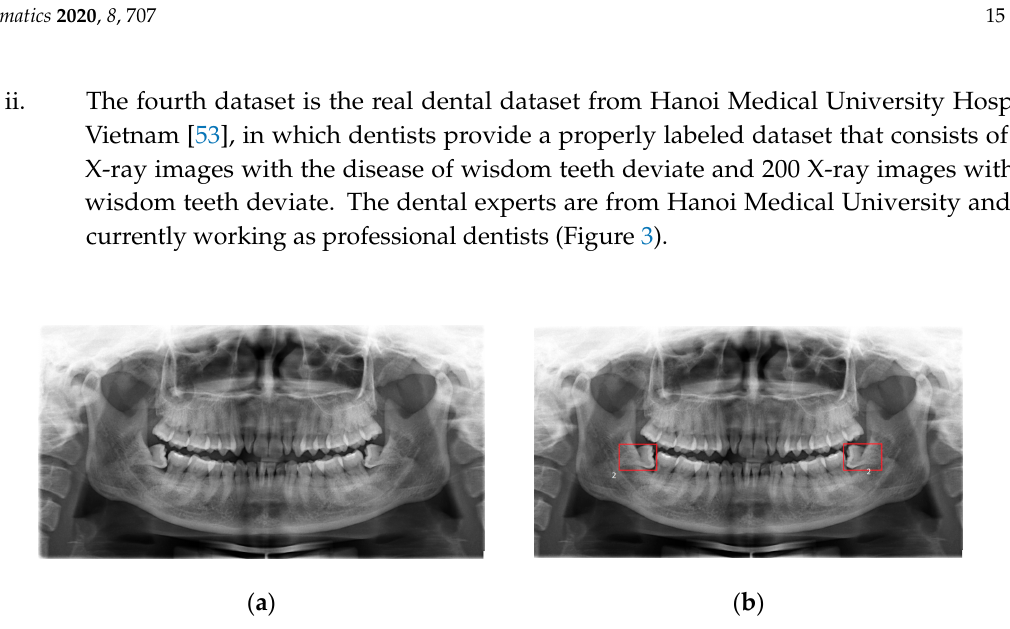
Figure 3. ( a ) A dental image. ( b ) The patient’s cavity area image.